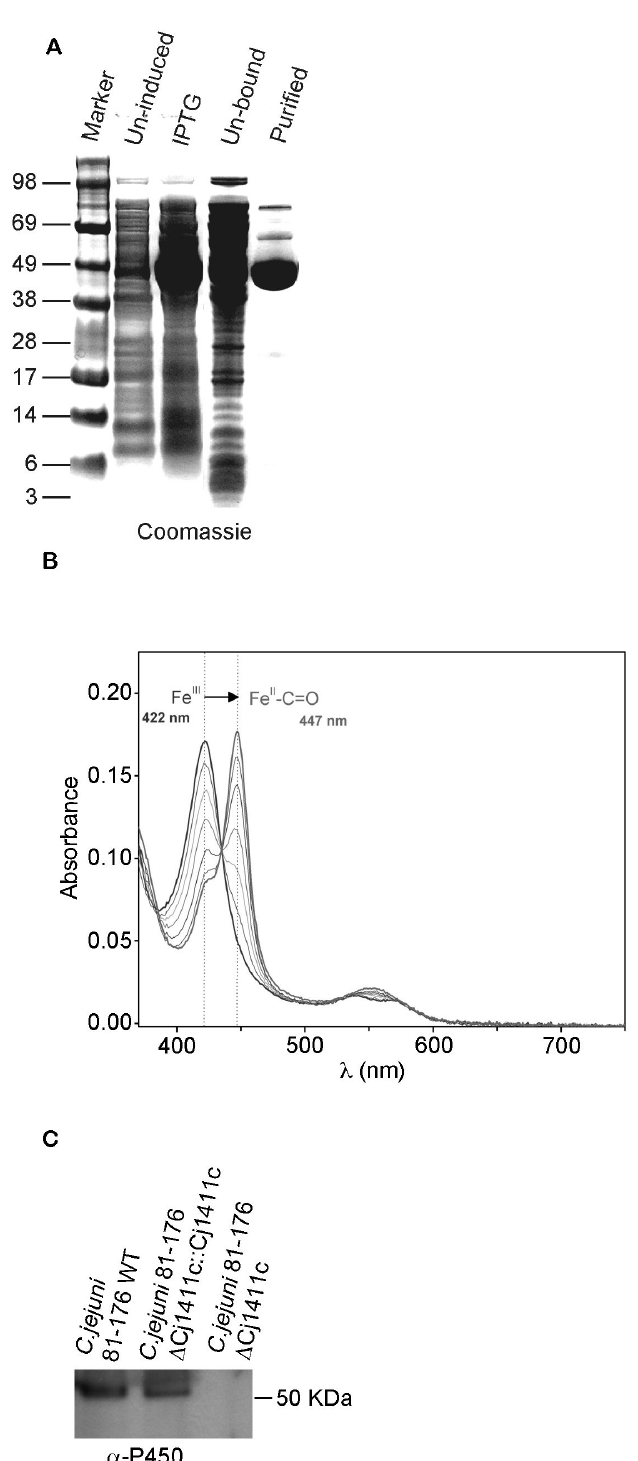
Figure 1. Cj1411c protein and mutant characterization. (a) Visualization of protein expression using 10% SDS-PAGE and stained with Coomassie Blue (b) Identification of the 450 nm absorption in the SORET band with CO bound on recombinant CYP1411c. Successive spectra show the oxidation transition from a 420 nm peak to a 450 nm peak in CYP1411c following exposure to CO. (c) Western blot analysis with an anti-CYP1411c antibody following gene deletion showing the absence of the cytochrome P450 protein in C. jejuni 81-176 Δ Cj1411c . doi: 10.1371/journal.pone.0075534.g001 PLOS ONE |